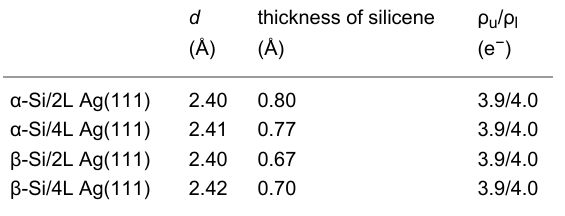
Table 1: The calculated silicene–substrate distance d , thickness of silicene and valence charges on upper-Si ( ρ u ) and lower-Si ( ρ l ) atoms of α -Si and β -Si on two-layer and four-layer Ag(111) surfaces.